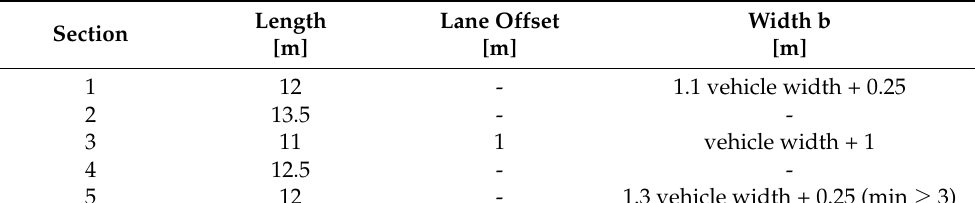
Figure 4. Track for the severe lane change (SLC) test. Table 2. Obstacle avoidance track dimension.